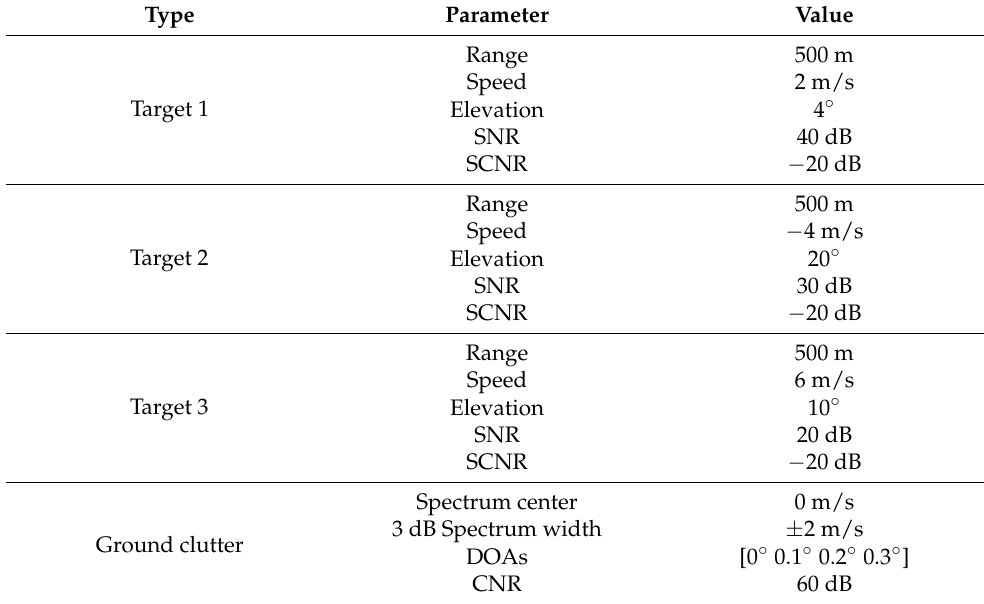
Figure 4. The experimental setup for the simulation. Table 3. Target and clutter parameters.